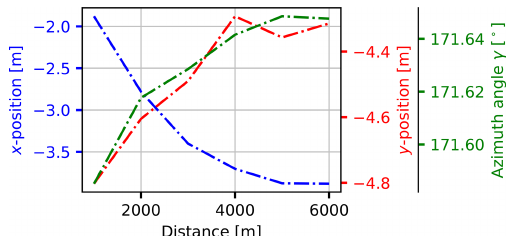
Figure 9. Result of the HT for increasing range (Scenario 2). The blue graph shows the evolution of the x coordinate over the range re- striction. The red graph shows the y coordinate and the green graph the azimuth angle.